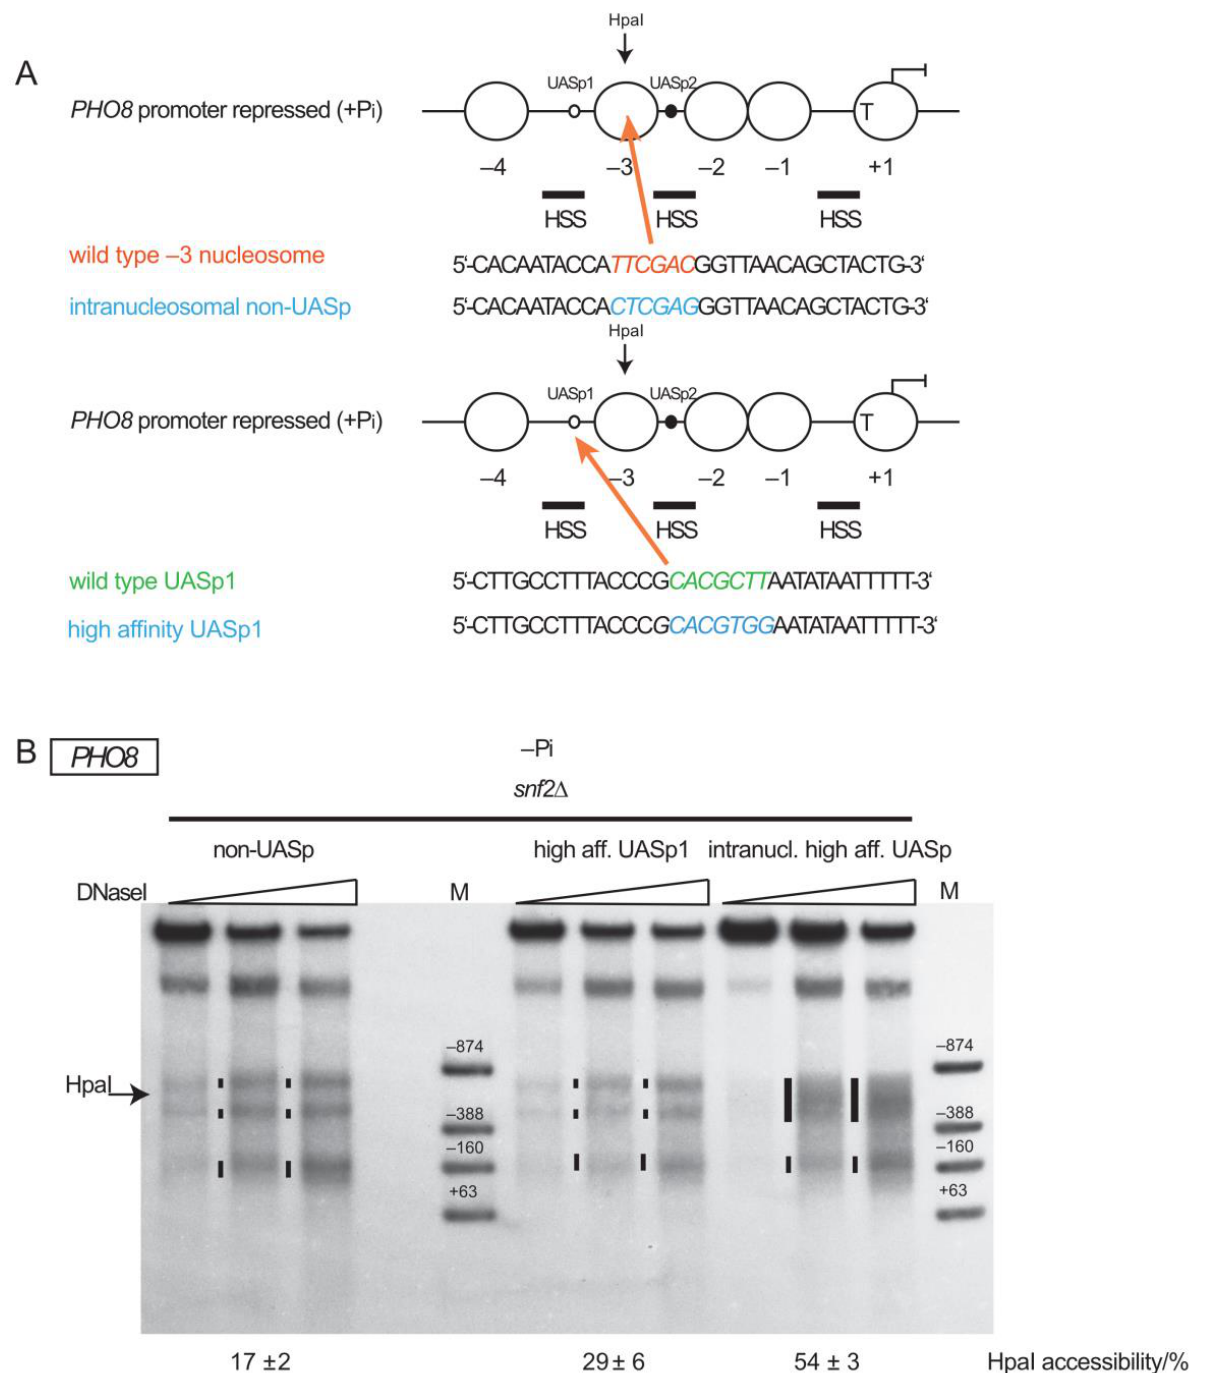
Figure 2. Neither introduction of an intranucleosomal scrambled non-UASp site nor of an additional internucleosomal high-affinity UASp site allowed PHO8 promoter opening without SWI/SNF activity. ( A ) Schematics analogous to Figure 1A showing the sequence changes for introduction of the scrambled non-UASp site in the − 3 nucleosome (top) and the conversion of the low affinity UASp1 site into a high-affinity site (bottom) in the plasmid locus. ( B ) DNaseI indirect end labeling for the PHO8 plasmid locus analogous to Figure 1C for the indicated genotypes and growth condition ( − P i ). Corresponding HpaI accessibility values analogous to Figure 1B are given below the blots. The condition − Pi snf2 ∆ intranucl. high aff. UASp is a biological replicate of the same condition in Figure 1C.